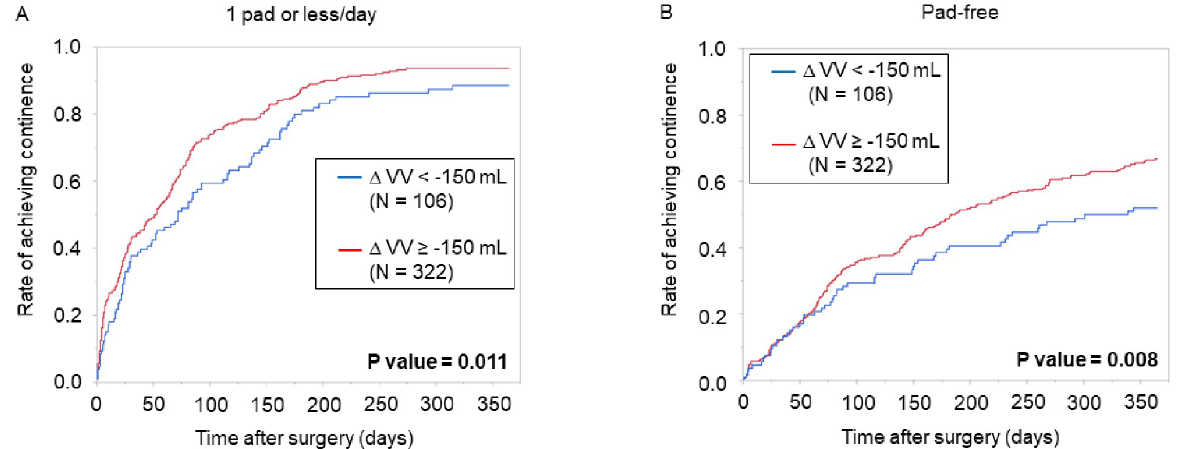
Fig 4. Post-RARP urinary continence recovery stratified by voided volume change. Kaplan-Meier curves for post-operative continence recovery to (A) use of 1 pad or less per day, and (B) pad-free status, as stratified by change in voided volume. A statistically significant difference was found for both curves, with a larger decrease in voided volume exhibiting a lower continence rate (log-rank test: P value = 0.011 and 0.008, respectively). Abbreviations RARP: robot-assisted radical prostatectomy Δ VV: perioperative change in voided volume.